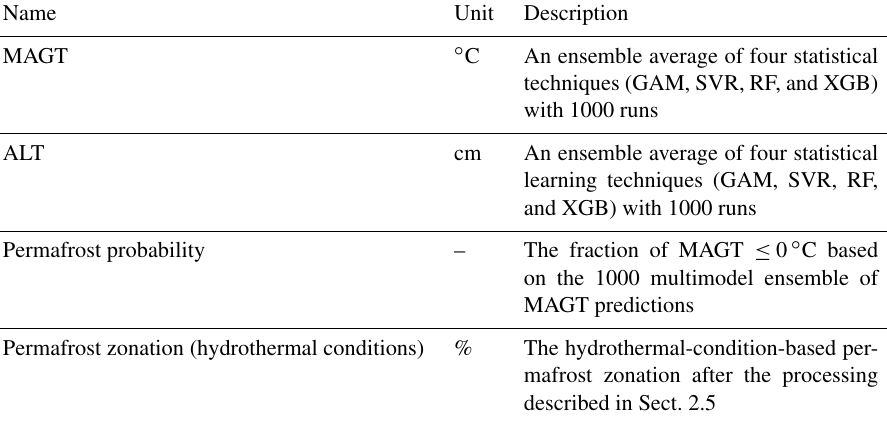
Table 4. The list of permafrost datasets for the Northern Hemisphere produced in this study (MAGT: mean annual ground temperature; ALT: active layer thickness; GAM: generalized additive model; SVR: support vector regression; RF: random forest; and XGB: extreme gradient